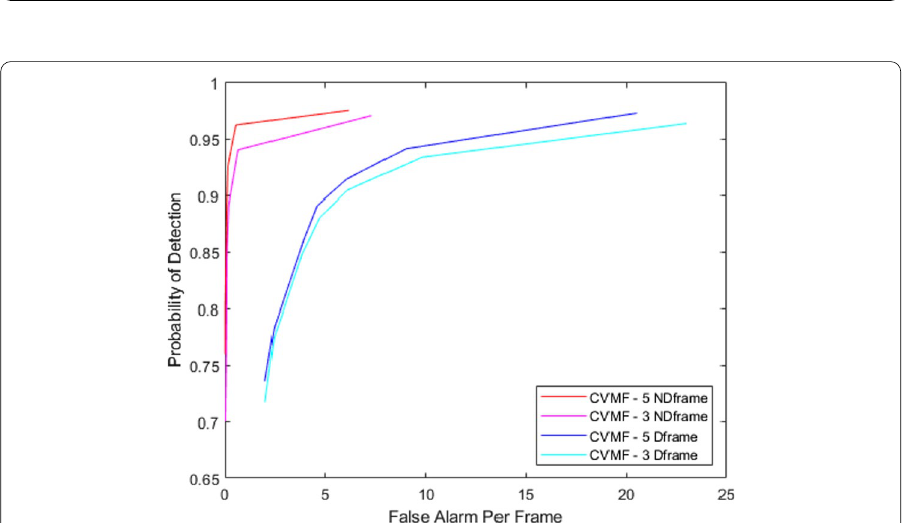
Fig. 12 CVMF normalized difference vs CVMF